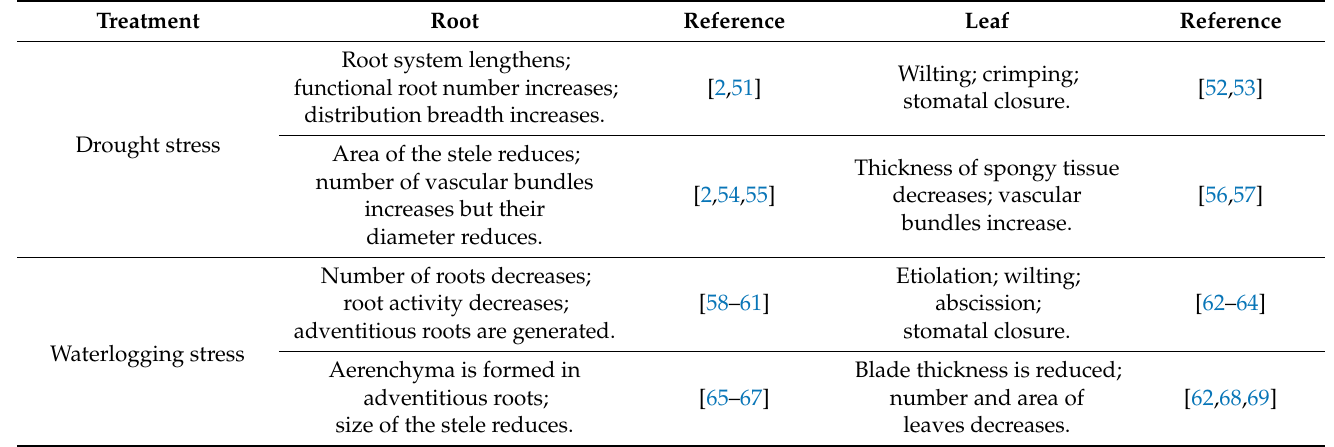
Table 1. Characteristics of plant roots and leaves under water